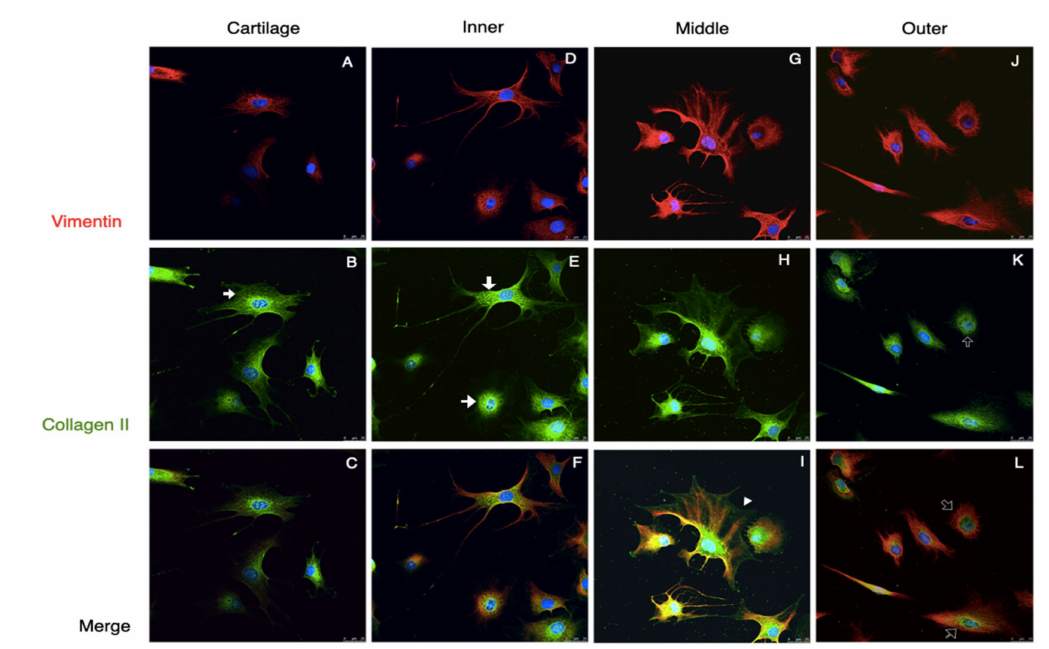
Figure 5. Collagen II and vimentin staining of the passage 2 cultured cells. Immunofluorescence demonstrated the vimentin and Col II staining of passage 2 cultured cells from the cartilage and meniscus. Two distinct cell morphologies were demonstrated in the meniscus. Vimentin staining presented a cytoskeletal-like pattern ( A , D , G , J ). Col II in the cartilage and inner cells exhibited fine mesh-like patterns, particularly in the cytosol (arrows in ( B , E )), but cells from the middle meniscus had overspread Col II from the cytoplasm along to the cells’ process (arrowheads in ( H )) whereas Col II in the outer meniscus cells was limited in the perinuclei area (hollow arrows in ( K )). In the merged channel, inner and middle meniscus presented both chondrogenic and fibrogenic staining ( F , I ), whereas the outer meniscus cells showed more fibrogenic-like staining ( L ) and chondrocyte demonstrated chondrogenic staning ( C ). Scale bars: 25 µ